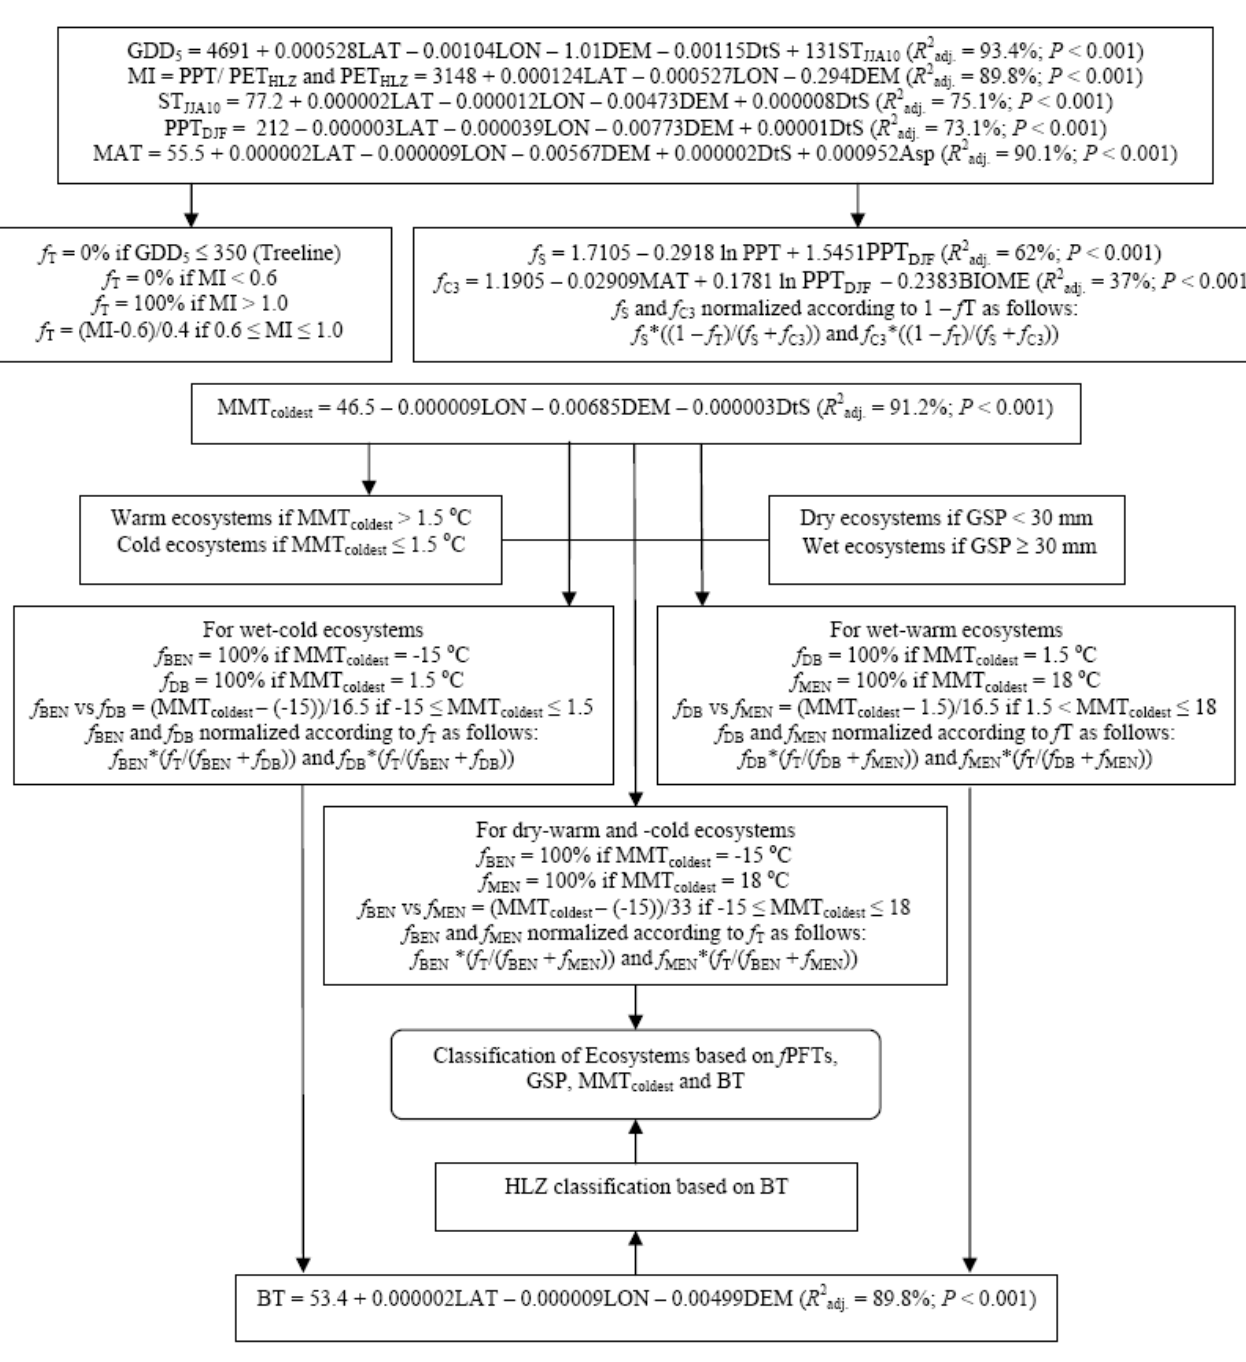
Figure 1. Biogeoclimatic classification algorithm of potential natural land cover and plant functional types (PFTs) in